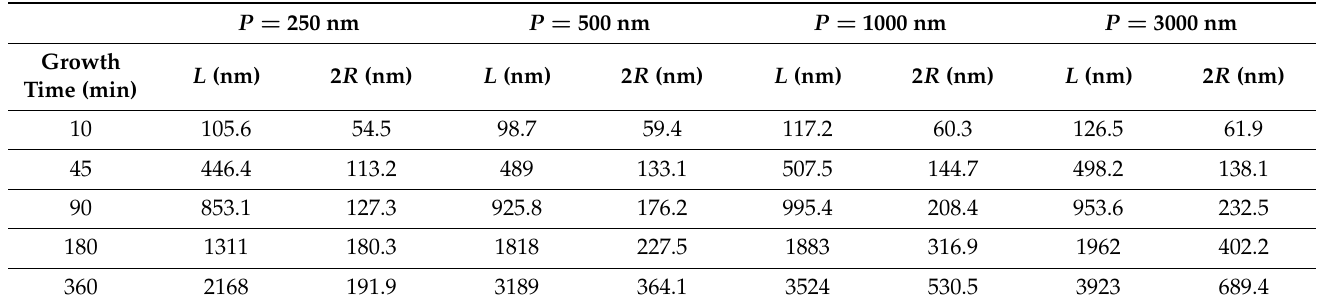
Table 3. Experimental data on the morphology of SAG InAs NWs [20].